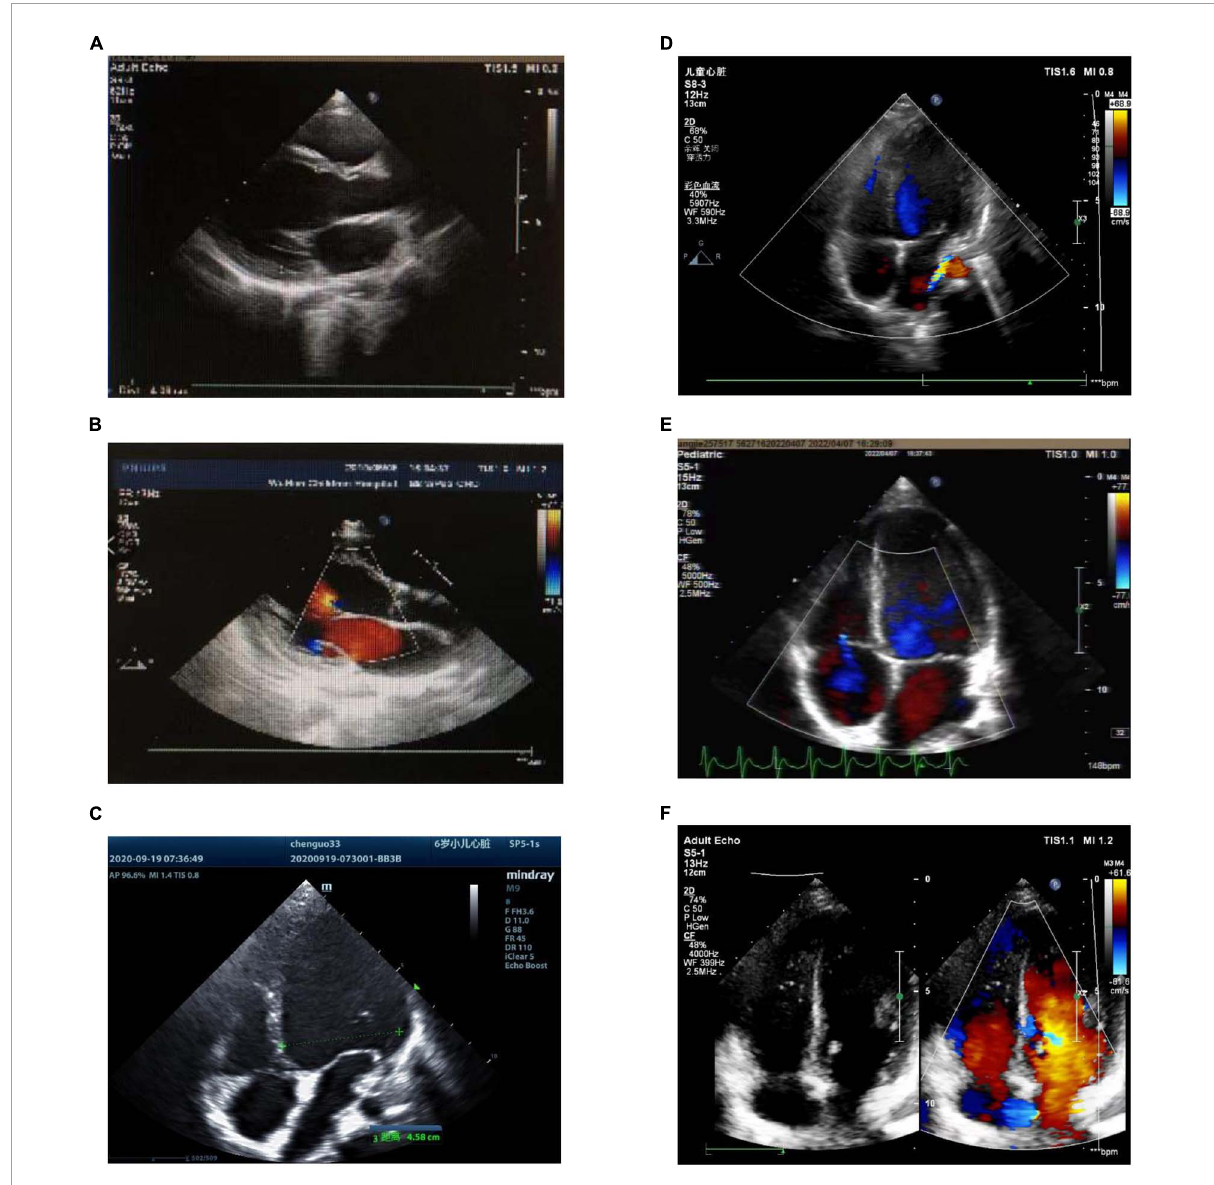
FIGURE4 Preoperative and postoperative echocardiography of atrial tachycardia (AT) from the atrial appendage. (A) Case 1: preoperative echocardiography. Left ventricular end-diastolic diameter (LVEDD) 40 mm, left ventricular ejection fraction (LVEF) = 42%. (B) Case 1: echocardiography 1 ◦ month after radiofrequency catheter ablation (RFCA). LVEDD 37 mm, LVEF = 53%. (C) Case 2: preoperative echocardiography. LVEDD 45.8 mm, LVEF = 29%. (D) Case 2: echocardiography 1 ◦ month after LAA resection. LVEDD 37 mm, LVEF =